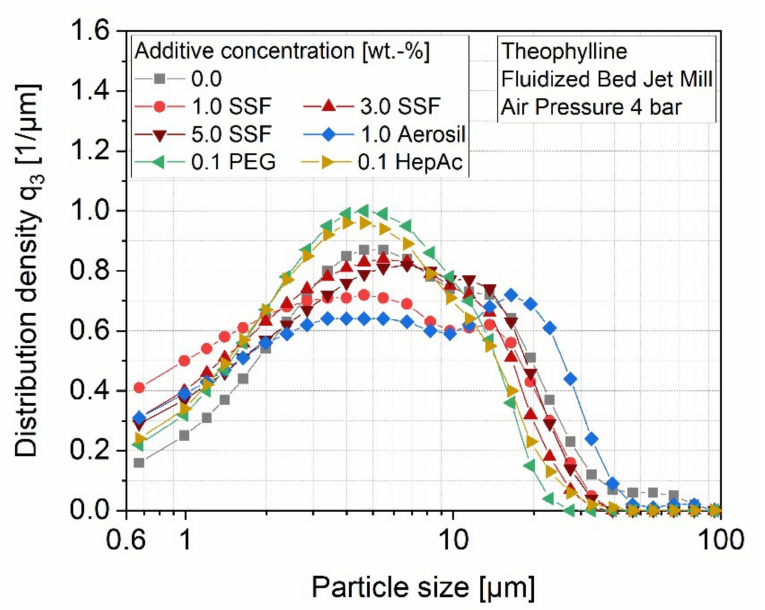
Figure 6. Impact of additives and additive concentration on the distribution density of theophylline.